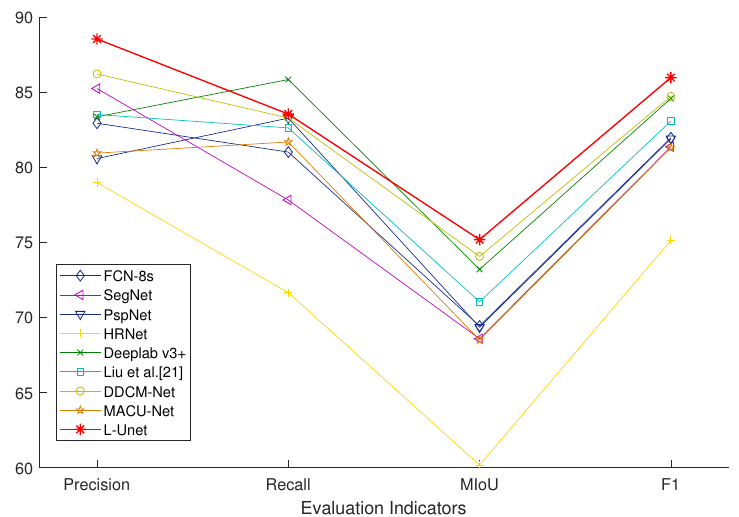
Figure 8. Comparison of the results of models FCN-8s, SegNet, PspNet, HRNet, Deeplab v3+, Liu et al. [21], DDCM-Net, MACU-Net and L-Unet for the four metrics precision, recall, MIoU and F1.